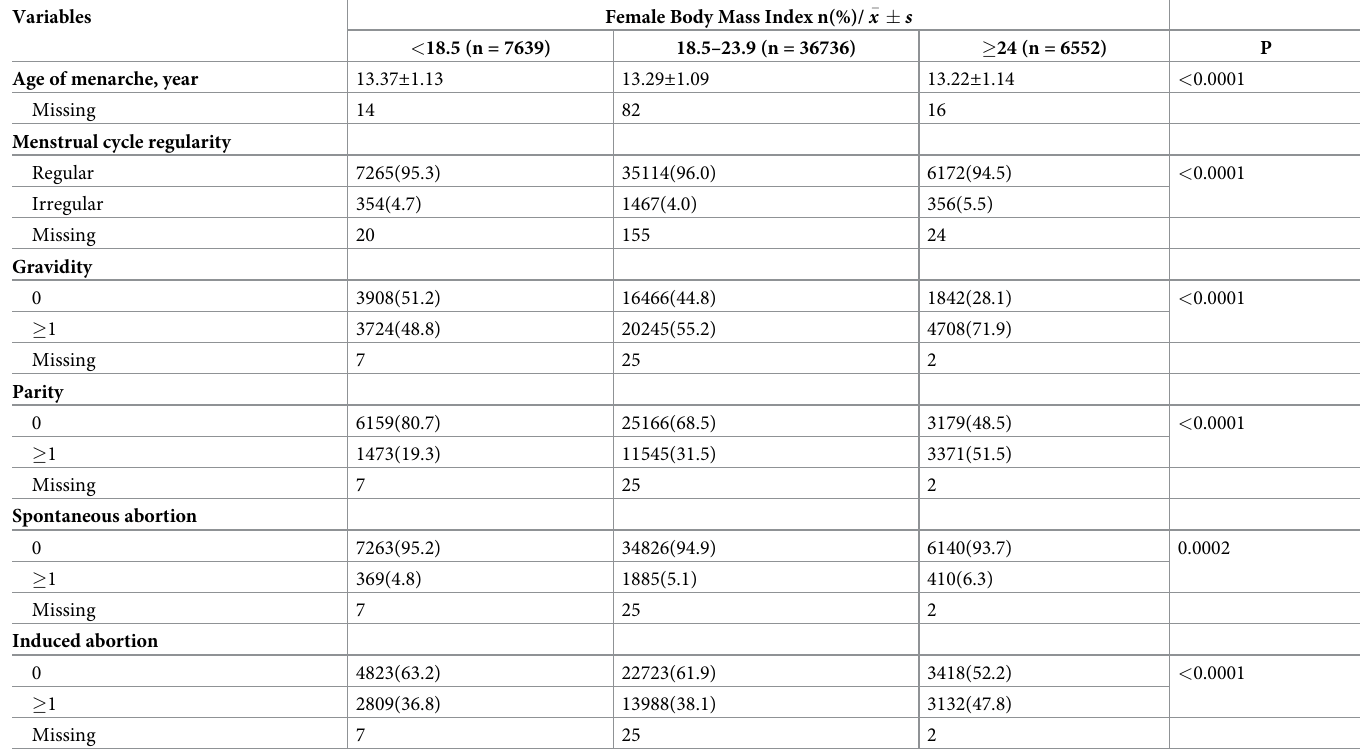
Table 2. Gynecological history of the women included in this study, stratified by BMI